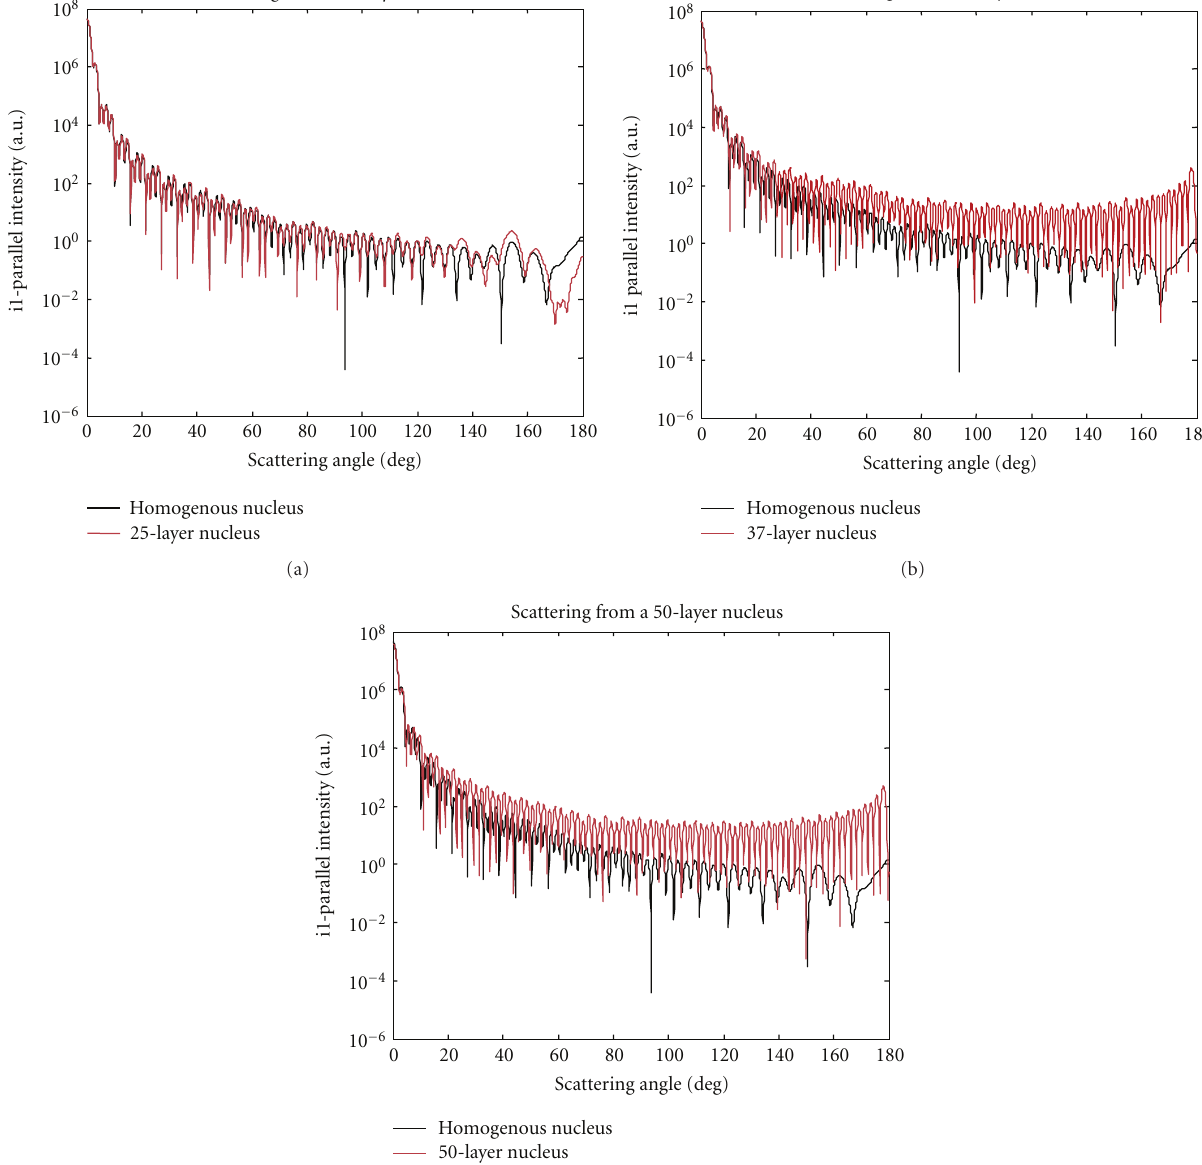
including protein concentration [32]. As the cell